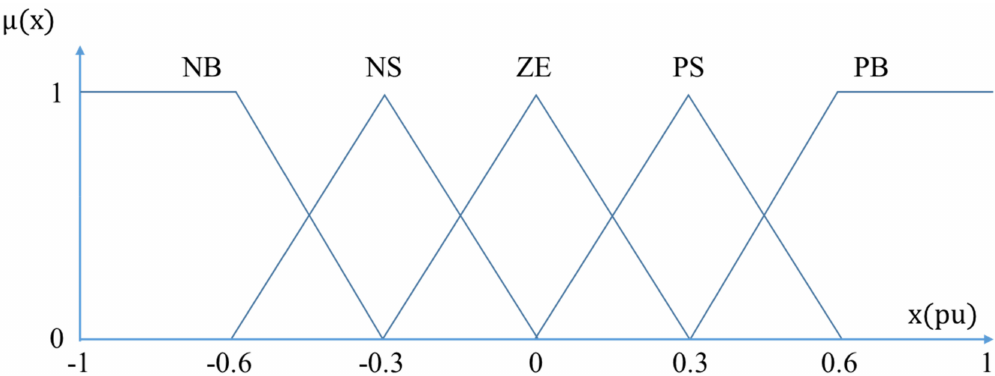
Figure 15. Membership function for inputs and output of fuzzy control.